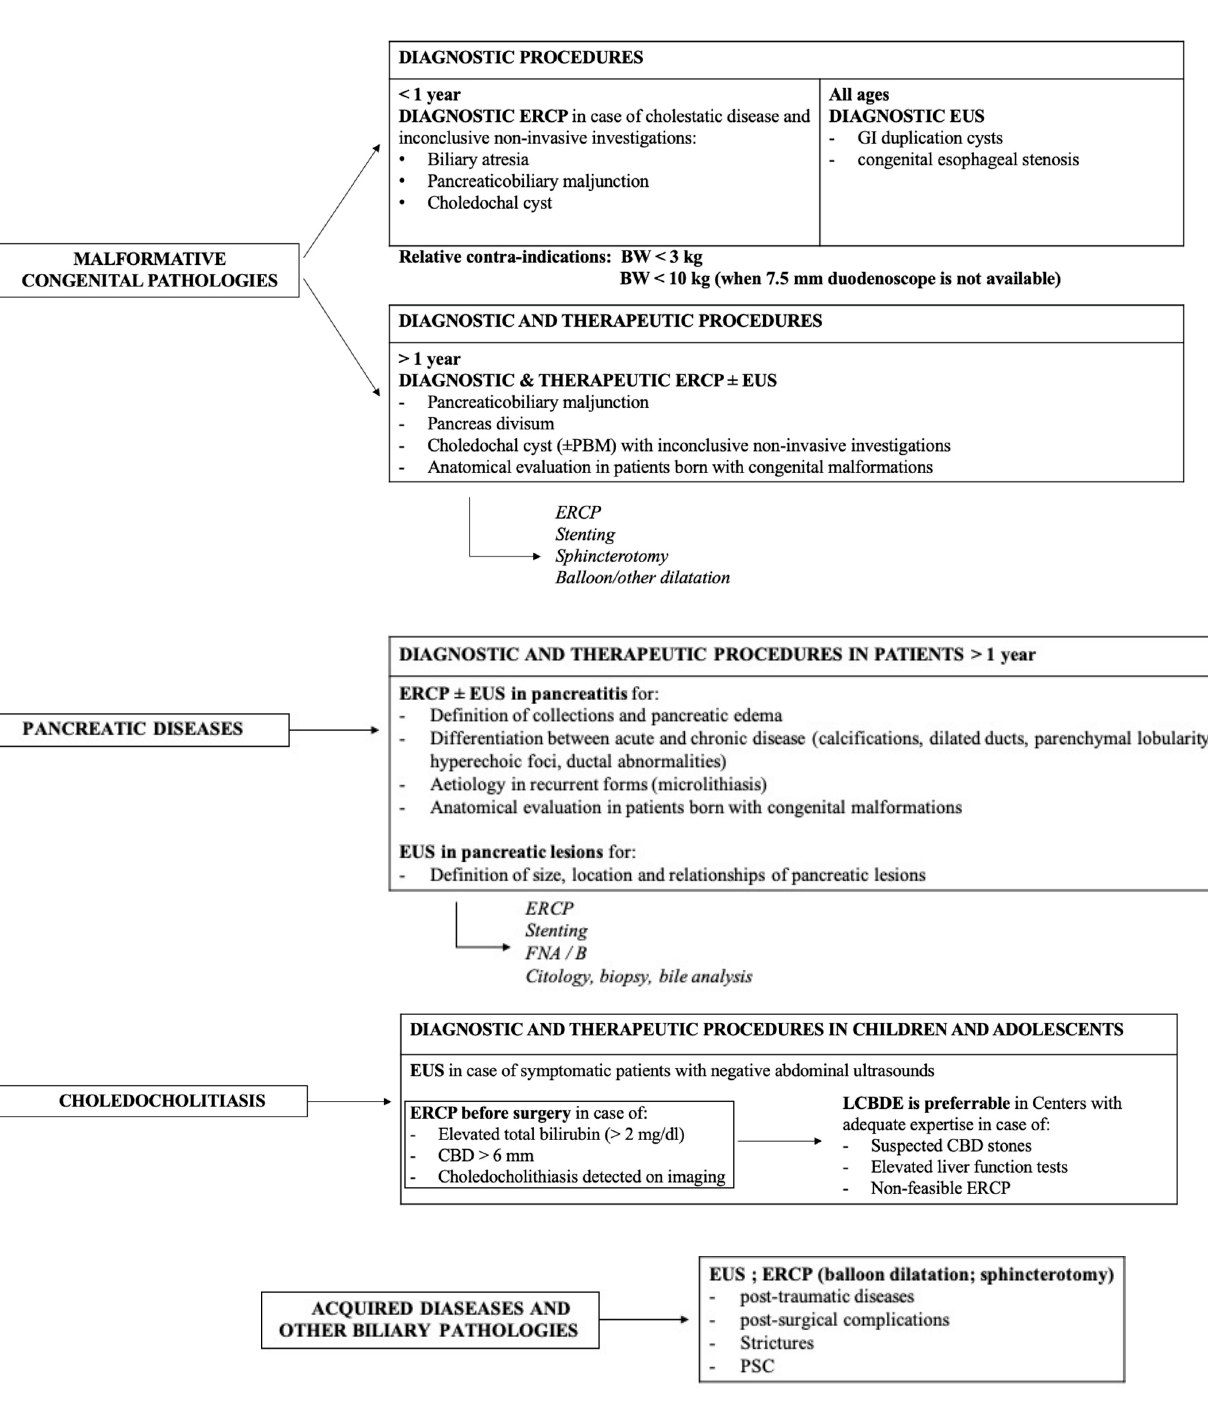
Figure 6. EUS and ERCP applications. PSC primary sclerosing cholangitis; PBM pancreaticobiliary maljunction; GI gastrointestinal; CBD common bile duct; LCBDE laparoscopic common bile duct exploration. They are modi fi ed based on ESPGHAN/ESGE/ASGE recommendations.